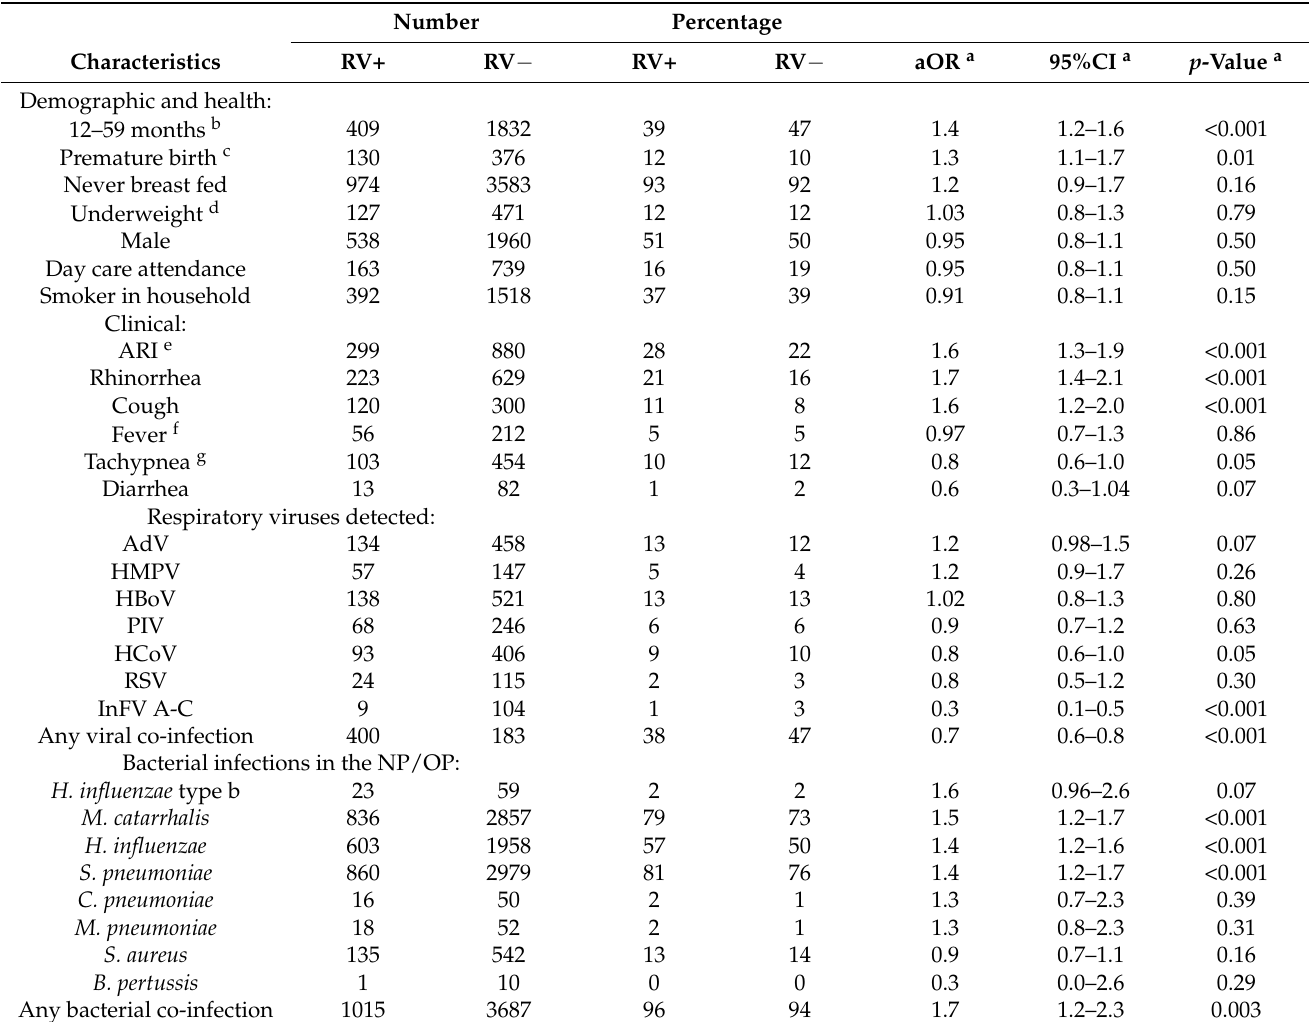
Table 1. Demographic and Clinical Characteristics and Respiratory Virus Co-infections among Community Controls with ( N = 1056) and without ( N = 3921) rhinovirus Infection, All PERCH